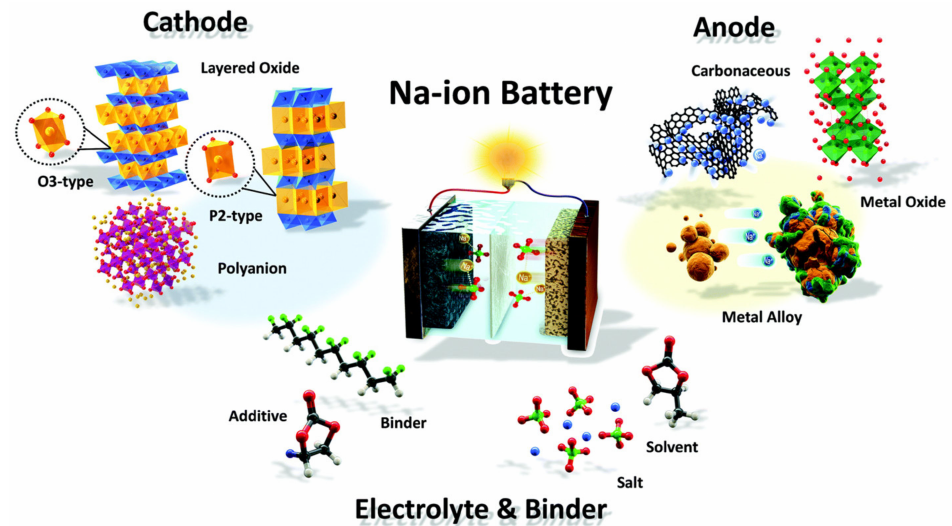
Figure 4. Schematic of the structure and illustration of a Na-ion battery system. Adapted